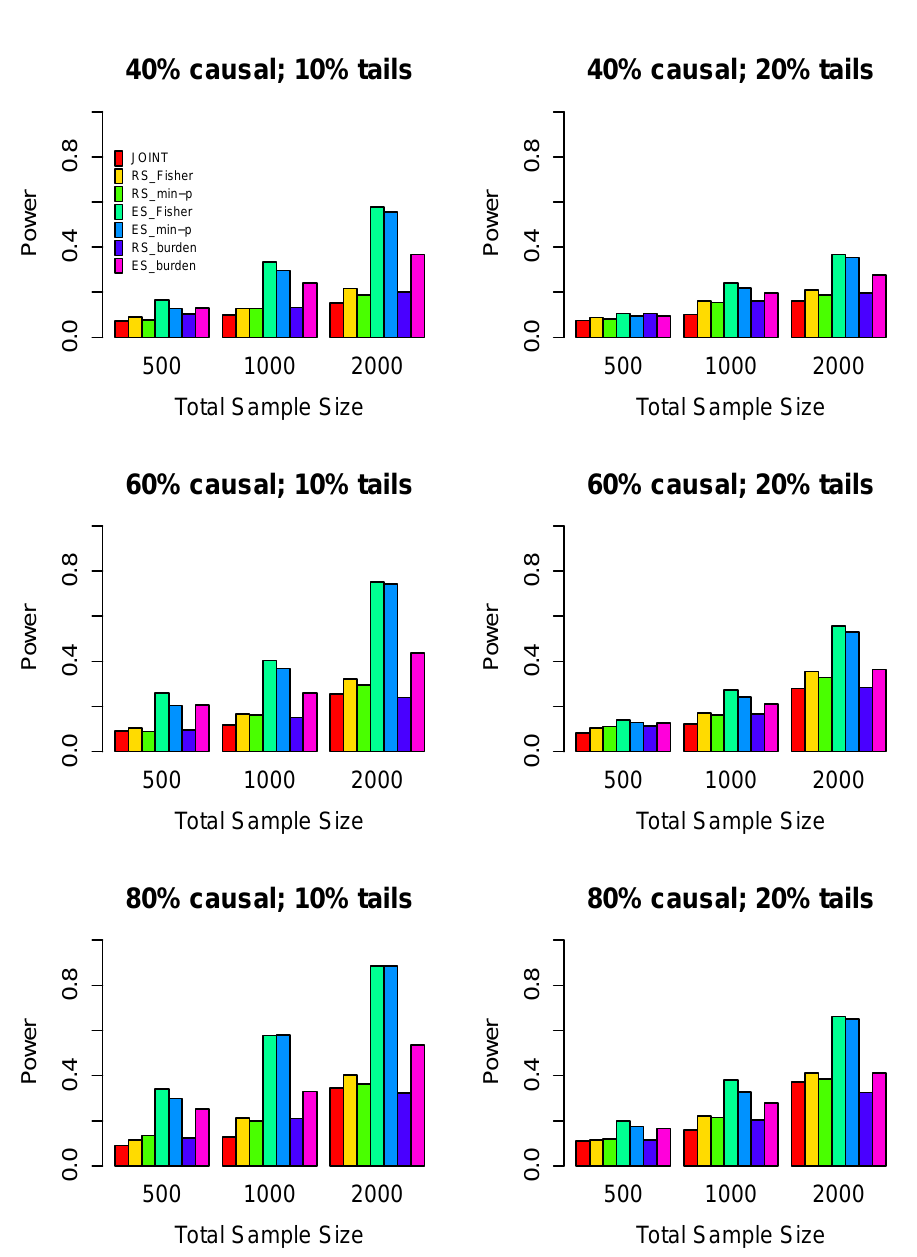
Figure 1. Power comparisons of seven tests when 50% causal variants have a positive effect on phenotype while the remaining 50% have a negative effect. The left panel considers 10% high/low extreme phenotype sampling with the three rows corresponding to 40%, 60%, and 80% causal variants. The right panel considers 20% high/low extreme phenotype sampling. Three sample sizes are considered: n = 500, 1000, 2000. Powers are estimated at the 0.05 significance